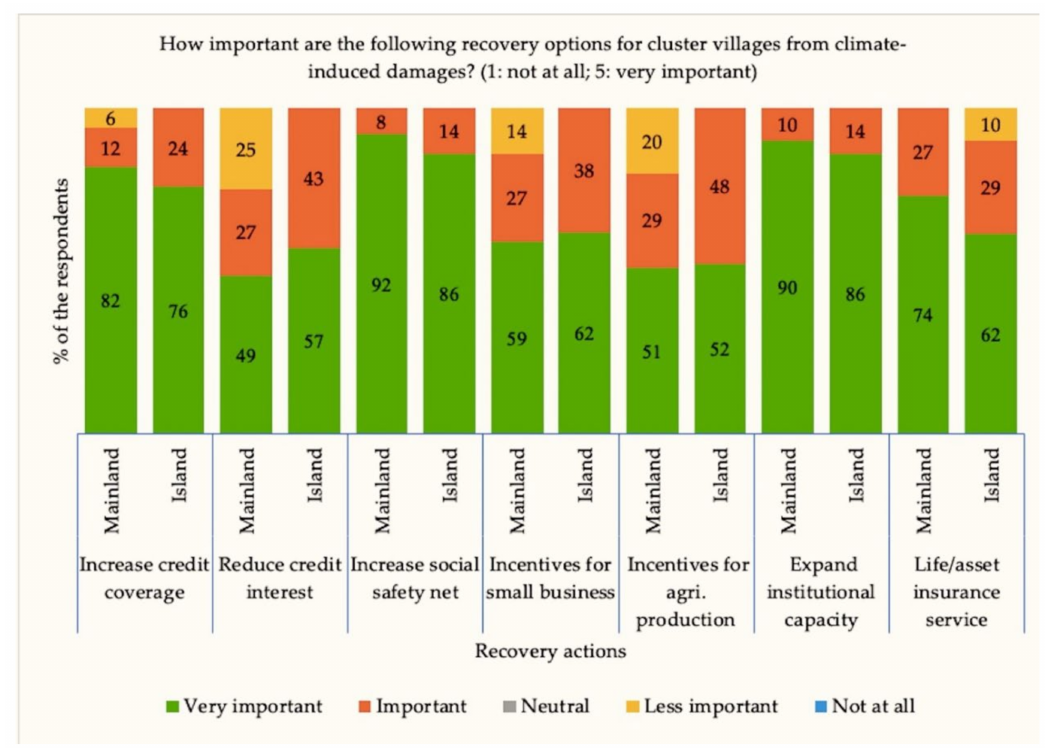
Figure 5. Perceptions about recovery measures from climate-induced damages in cluster